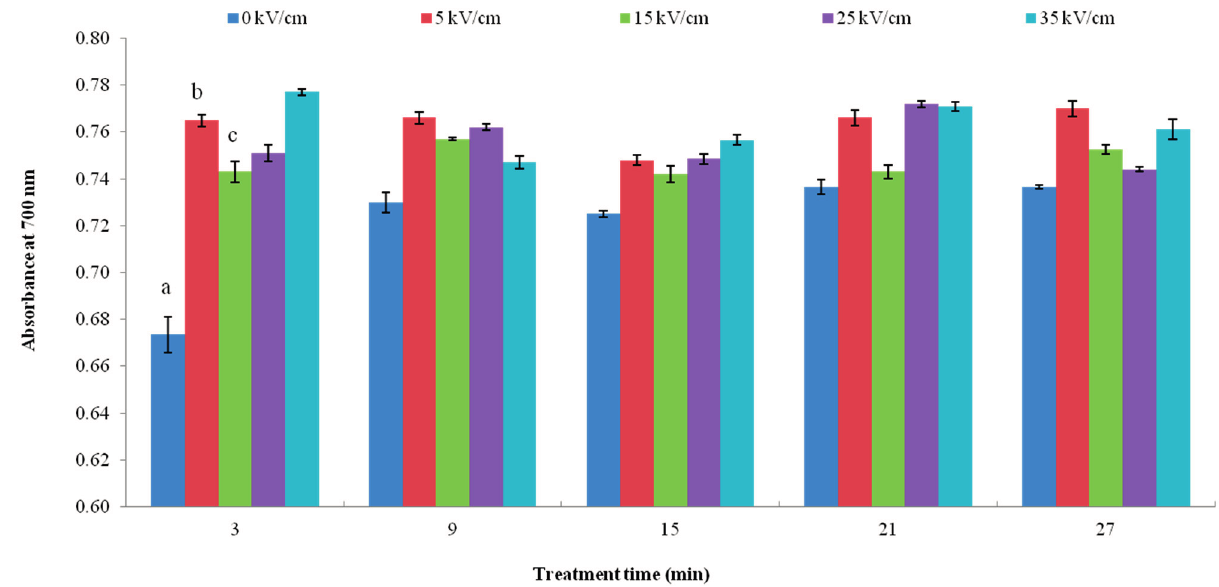
Figure 6. Reduce power activity of VIT-C by PEF treatments. Values in columns followed by different letters mean significant difference ( p <